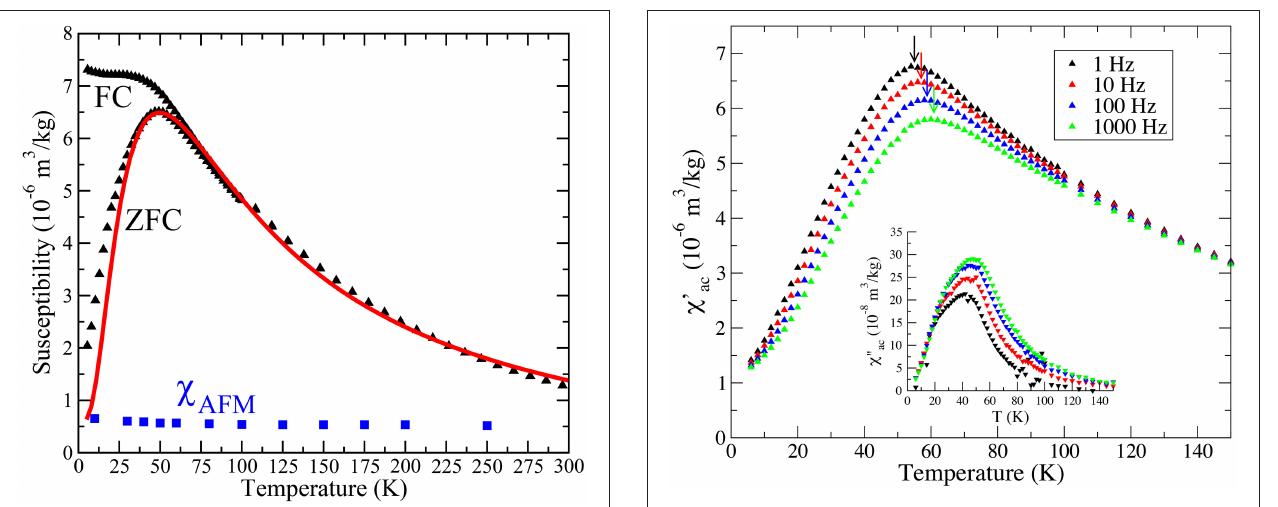
FIGURE 8 | ZFC and FC branches of the susceptibility vs. temperature in lepidocrocite measured with a field of 5 mT and cooled with the same field in the FC procedure. The red curve is a calculation of the ZFC susceptibility using a model of independent volume distributed particles (see text). The blue points represent the AFM susceptibility